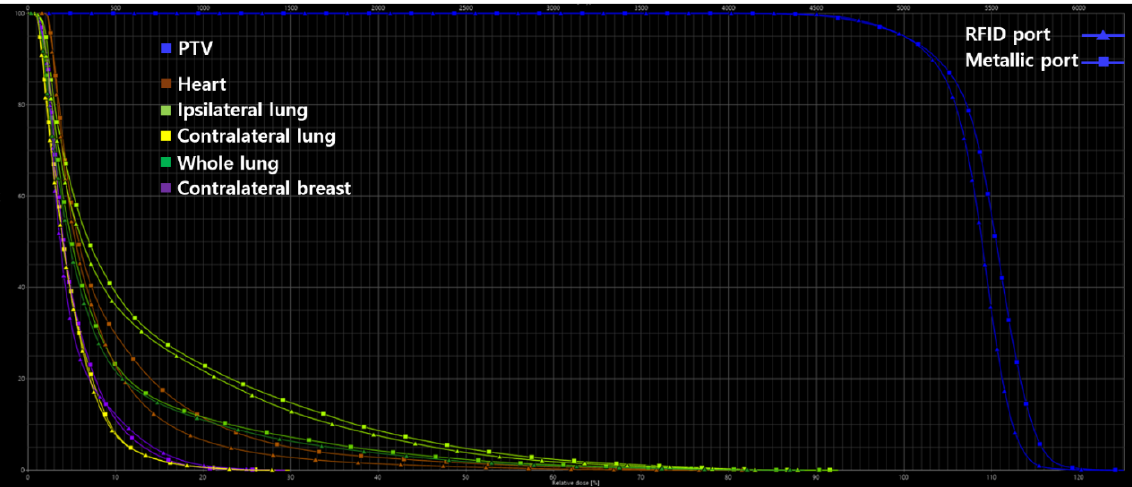
Figure 4. T he dose distributions for the radio frequency identification ports and metallic ports in axial view. The isodose lines correspond to 110% (red), 105% (pink), 100% (yellow), 95% (orange), 90% (green), 85% (cyan), 80% (blue), 70% (light green), 50% (brown), 30% (dark green), and 15% isodose (dark blue). ( a ) RFID port; ( b ) metallic port.